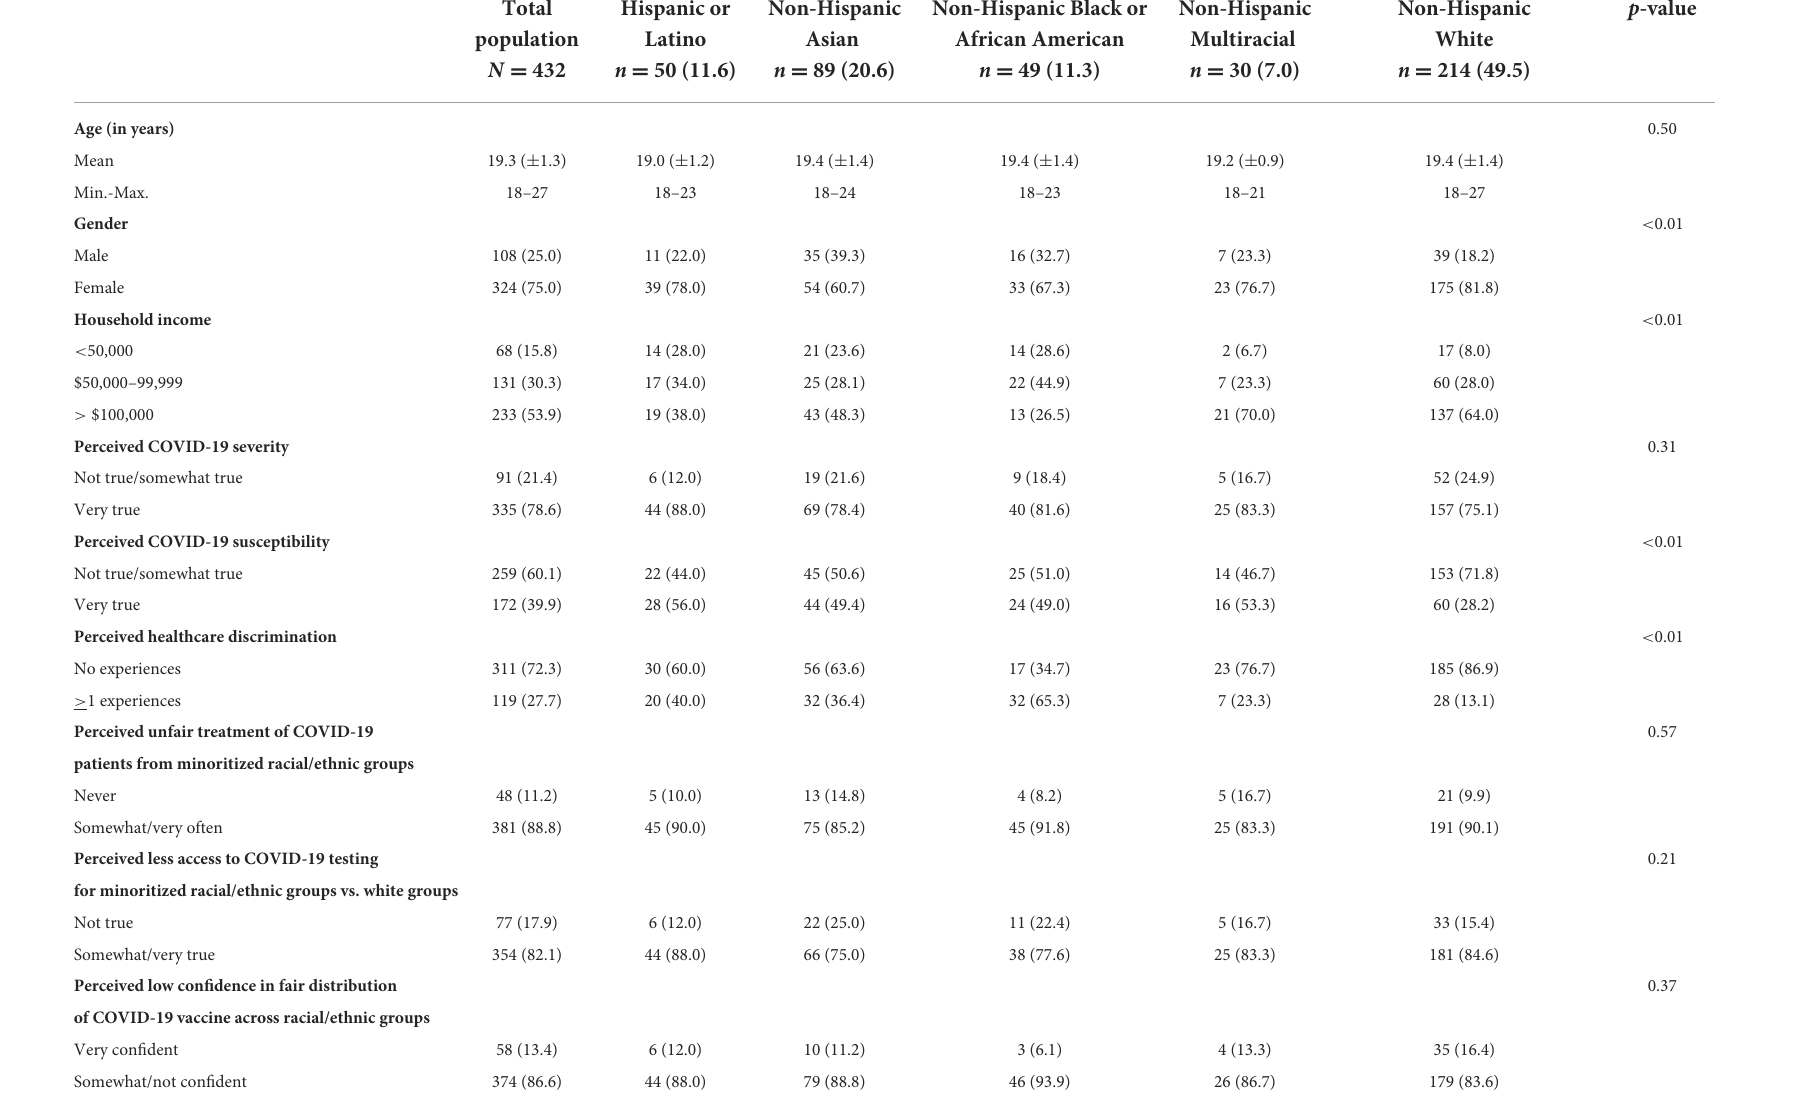
TABLE 1 Characteristics of the study